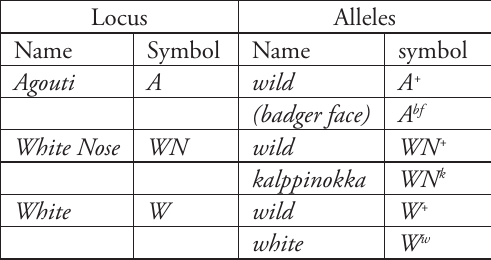
Table 3. Coat colour loci segregating in the Ahven- järvi